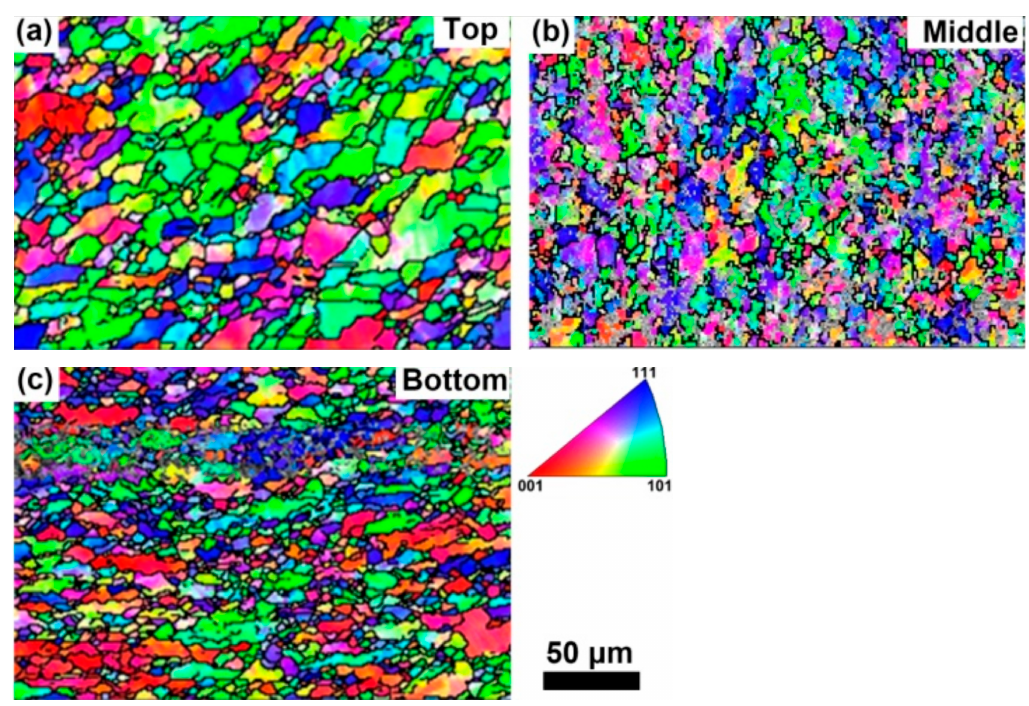
Figure 6. EBSD reconstructed microstructure: ( a ) Top of NZ; ( b ) Middle of NZ; ( c ) Bottom of NZ.